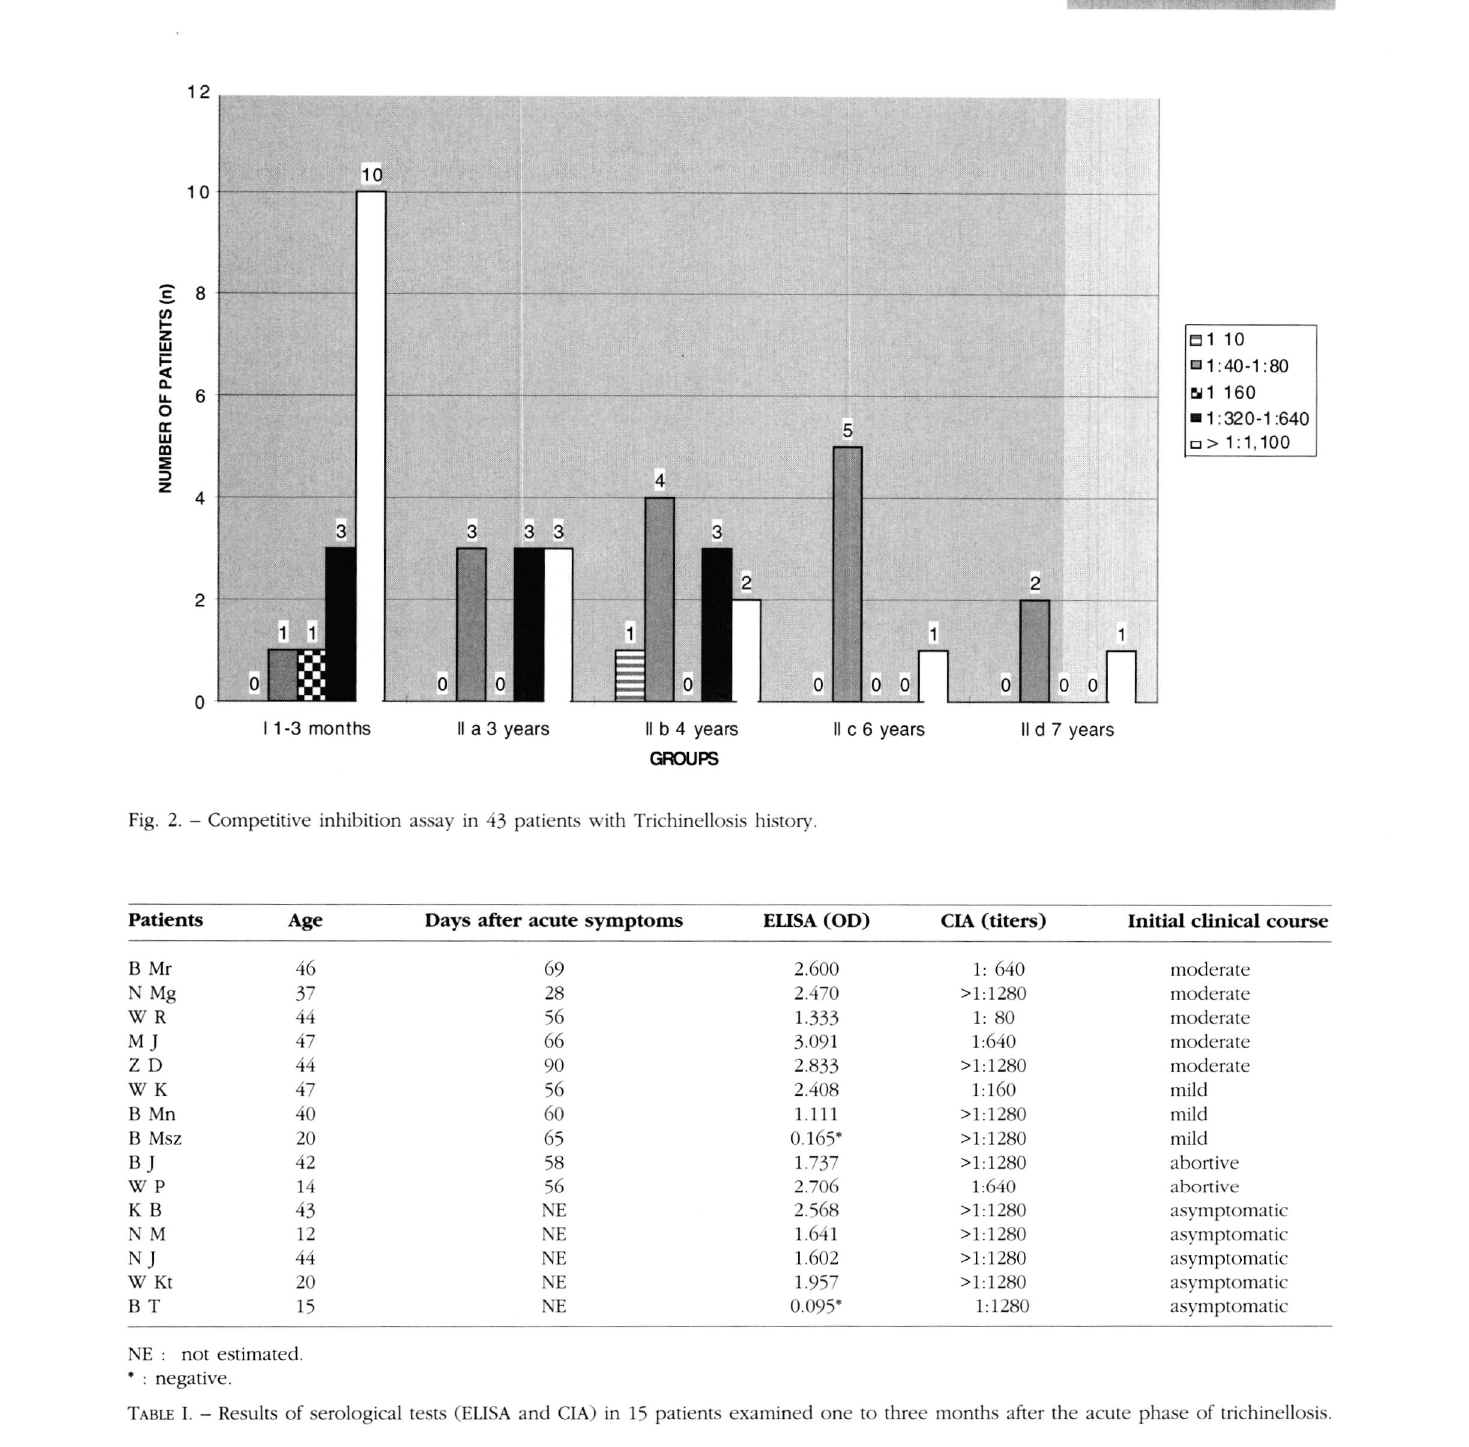
Fig. 2. - Competitive inhibition assay in 43 patients with Trichinellosis